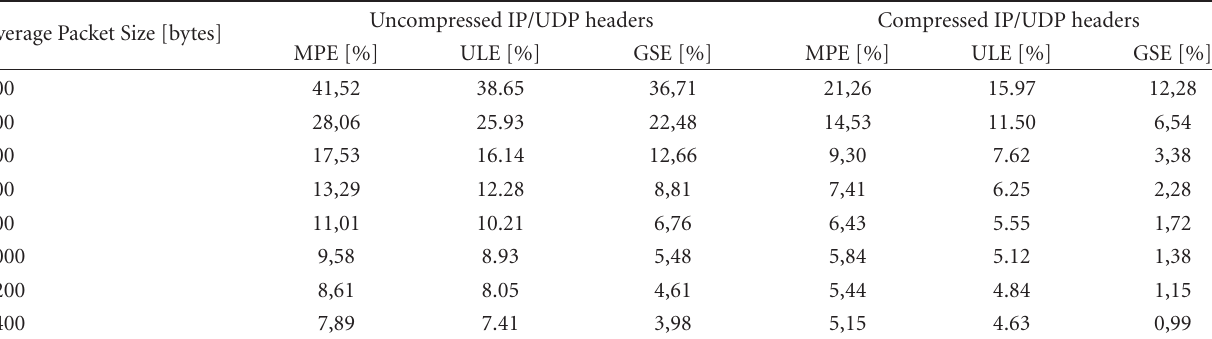
Table 4: Transmission overheads.